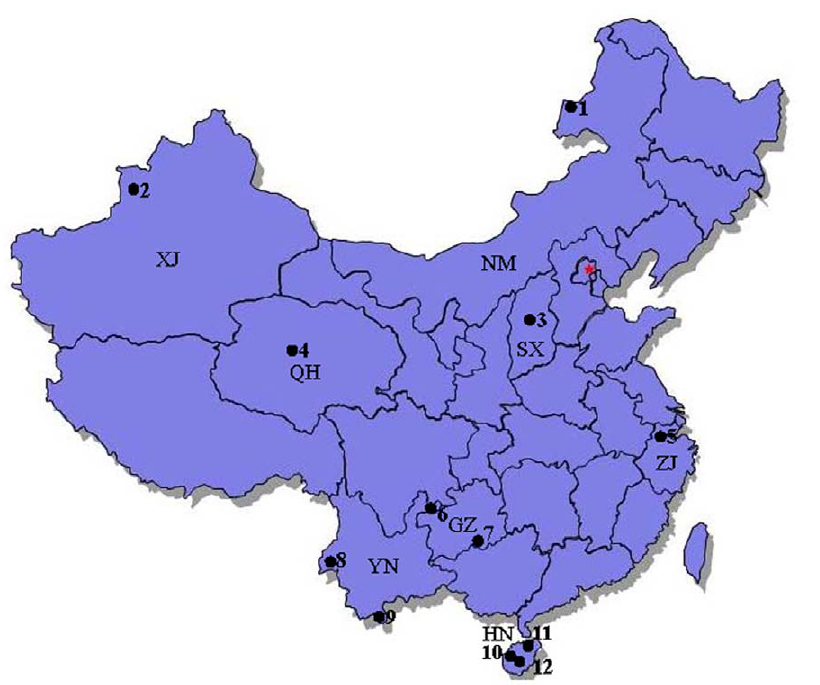
Figure 1. Map of the study area showing the sampling sites of mosquitoes collected in this study. Site 1: Manzhouli City, Neimeng ProvinceXinjiang; Site 2: Yili, Kazakh Autonomous Prefecture, Xinjiang Province; Site 3: Taiyuan City, Shanxi Province; Site 4: Golmud River, QinghaiQinghai Province; Site 5: Tianmu Mountain, Zhejiang Province; Site 6: Zhenxiong County, Yunnan Province; Site 7: Maolan Natural Reserve, Guizhou Province; Site 8: Ruili City, Yunnan Province; Site 9: Mengla County, Yunnan Province; Site 10: Changjiang County, Hainan Province; Site